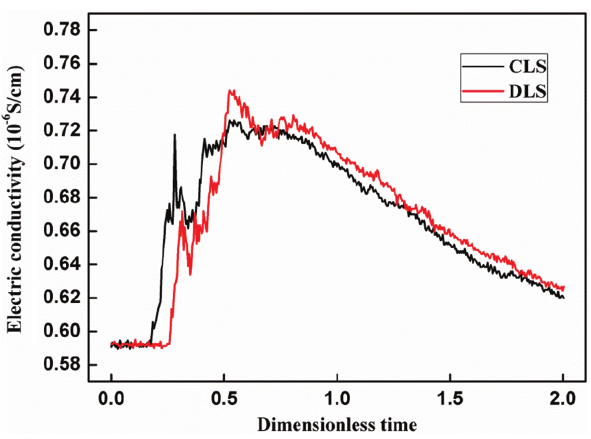
Figure 8: RTD curves of different ladle shrouds in the one-third scale